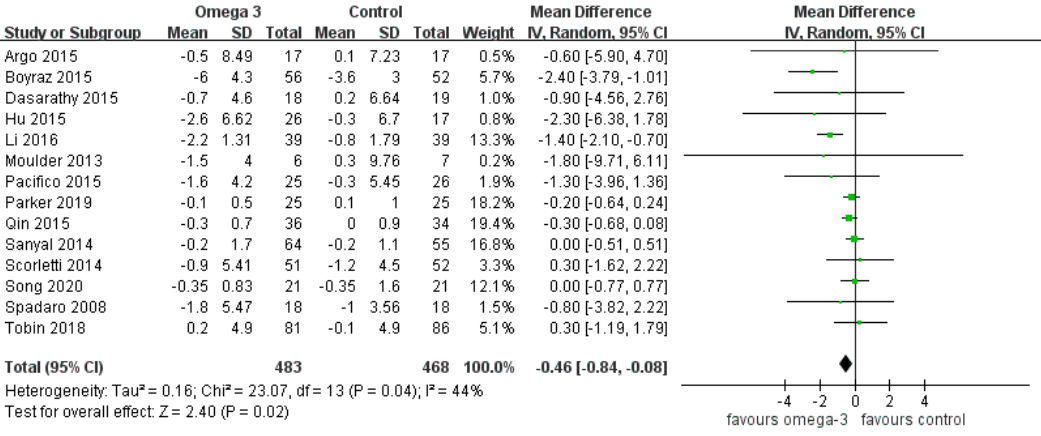
Figure 6. Effect of omega-3 fatty acid on fasting blood sugar and HOMA-IR. ( A ) Effect on homeostatic model assessment for insulin resistance. ( B ) Effect on fasting blood sugar.